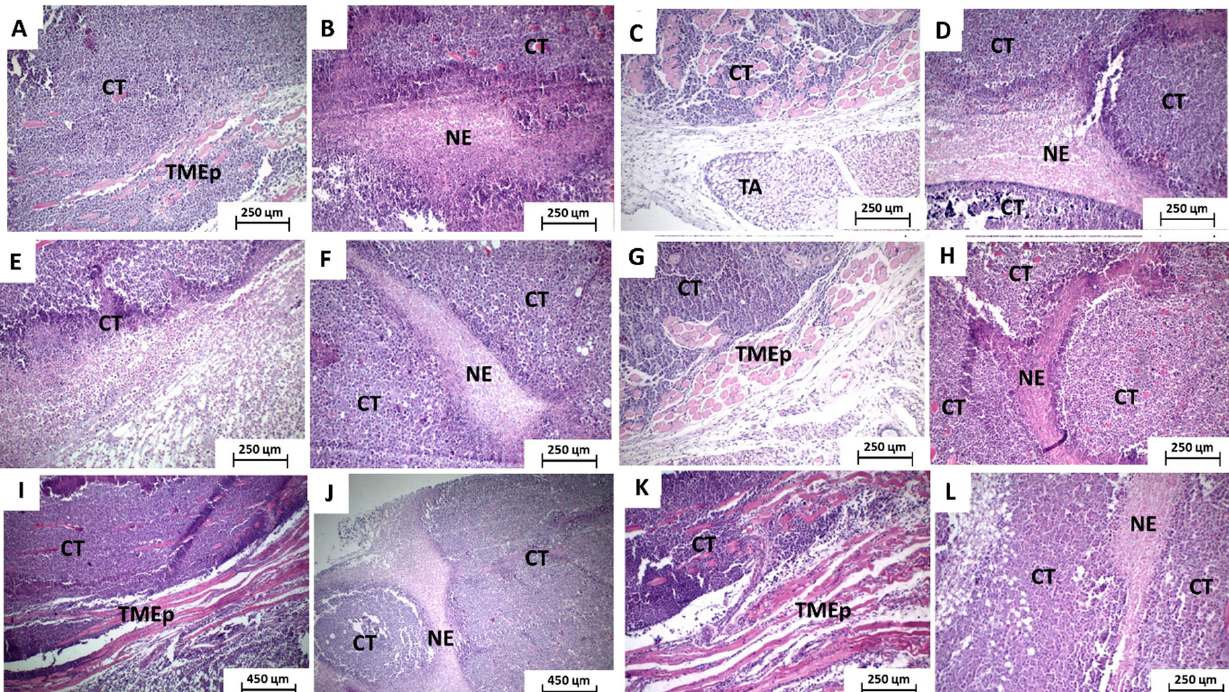
Figure 3. Photomicrographs of HE-stained histological sections of surgical specimens of sarcoma 180 implanted in rodents. ( A ) vehicle group showing tumor with infiltrative and irregular margins, invading and dissociating peripheral muscle tissue and ( B ) forming solid intraparenchymal blocks of coagulative necrosis. ( C ) 5-FU group showing regular tumor margins, with a more expansive growth pattern and ( D ) thin bands of coagulative necrosis forming a trabecular pattern. ( E ) Group treated with 100 mg/kg of the extract showing very infiltrative tumor margins and ( F ) forming thick intraparenchymal bands of coagulative necrosis. ( G ) Group treated with 200 mg/kg showing much more regular tumor margins and ( H ) trabeculae of intratumoral coagulative necrosis. ( I , J ) Group treated with 5-FU associated with 100 mg/Kg and ( K , L ) 200 mg/kg of the extract exhibiting regular tumor margins compressing peripheral skeletal striated muscle tissue and thin trabeculae of intratumoral coagulative necrosis. Caption: CT—viable tumor cells; NE—coagulative necrosis; TMEp—skeletal striated muscle tissue; TA—subcutaneous adipose tissue (×100).